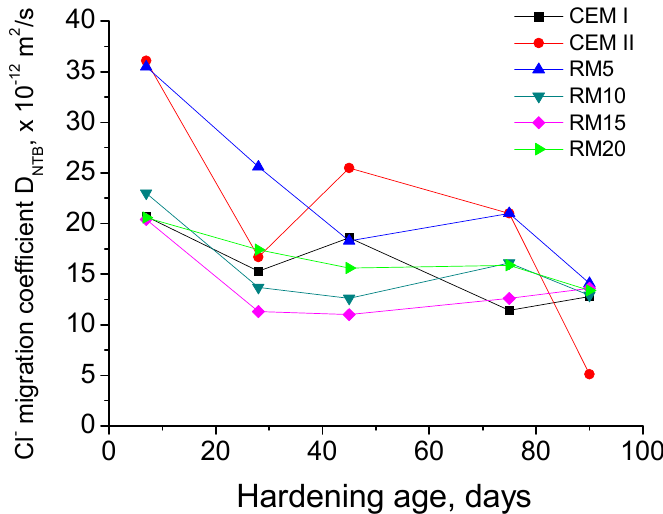
Figure 10. Results of the non-steady-state chloride migration coefficient for the studied mortars.